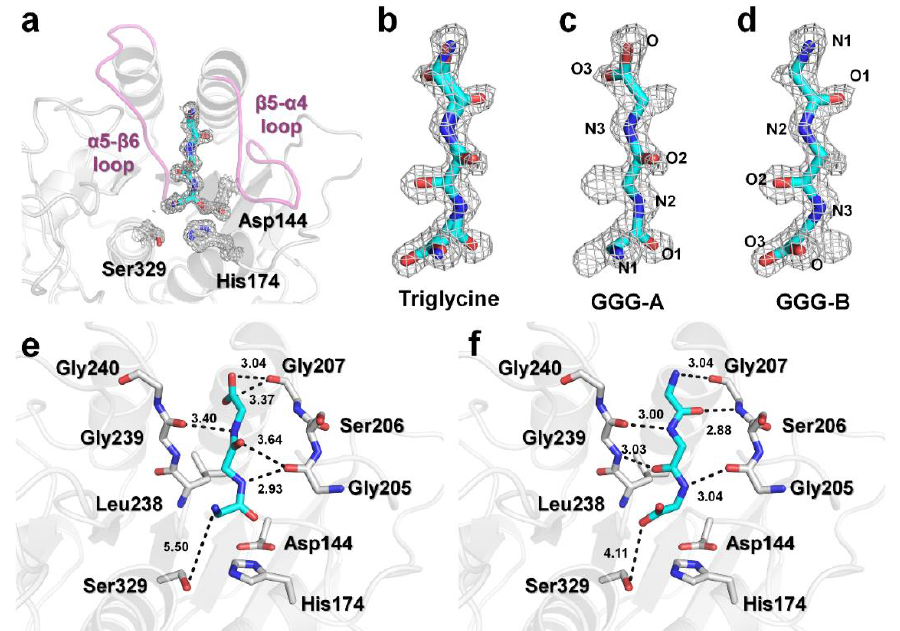
Figure 2. Binding conformations of triglycine on PaProK. ( a – d ) 2Fo-Fc electron density of a triglycine on PaProK (grey colored mesh, 1.0 σ). ( a ) Triglycine is located between β 5– α 4 and α 5– β 6 loops (pink). ( b ) Electron density maps reveal two conformations of triglycine. ( c ) GGG-A and ( d ) GGG-B forms of triglycine molecules fitted into the electron density map. Interactions between PaProK with ( e ) GGG-A and ( f ) GGG-B.